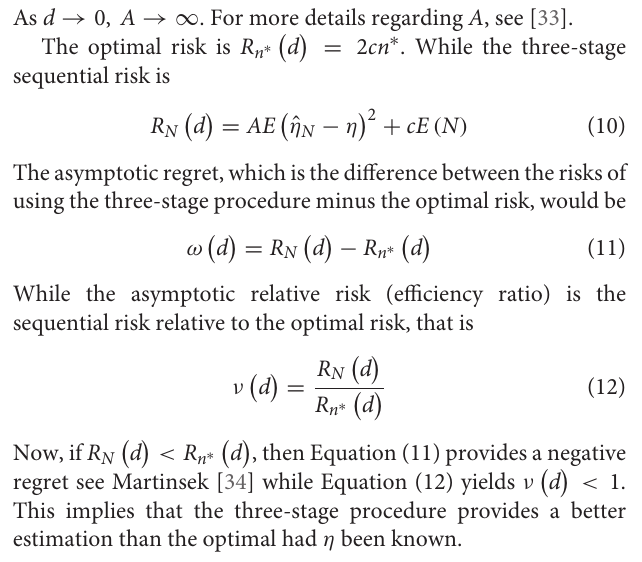
10, σ 0.5, 1, 2, 10 = =